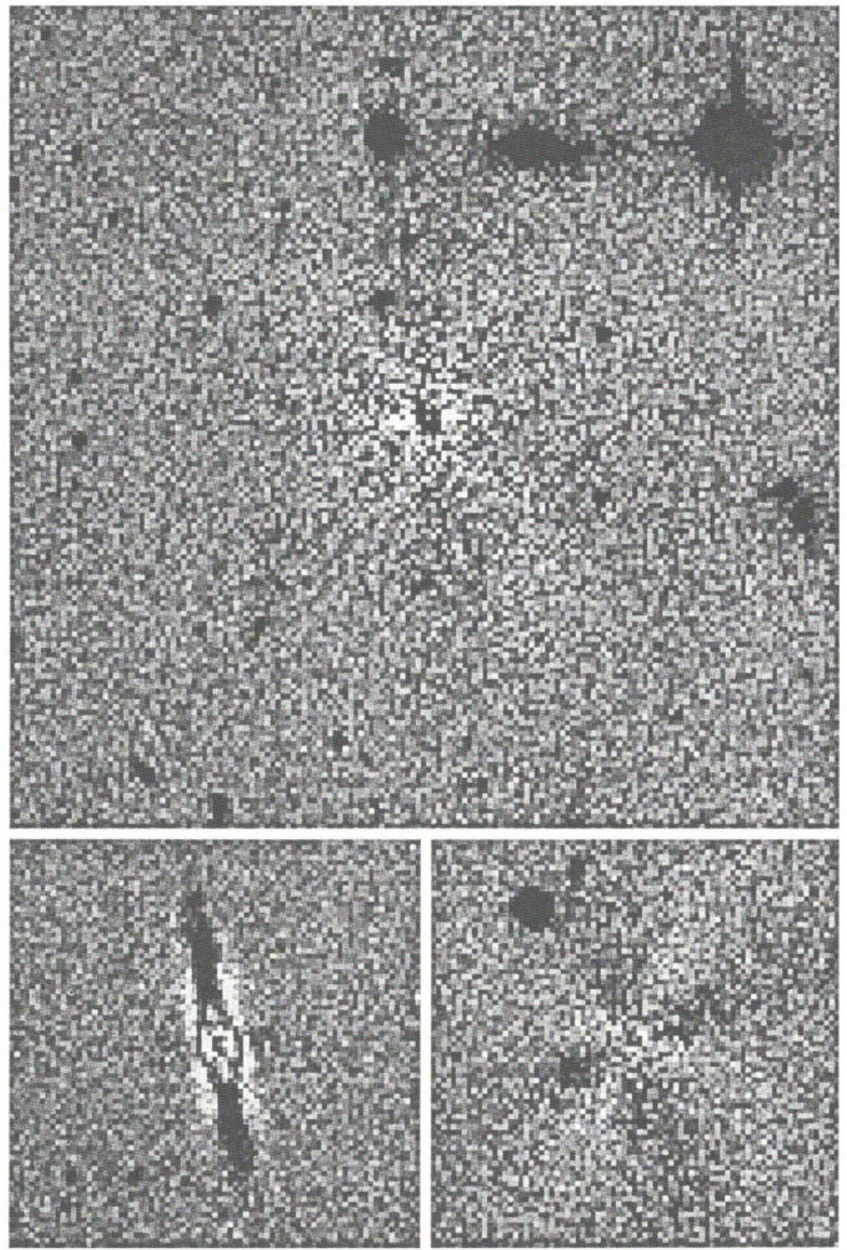
Fig. 3. The three example galaxies: residual images (i.e. the original image minus the model image). The intensity scaling is linear, and the cuts are symmetrical around zero. Black represents positive